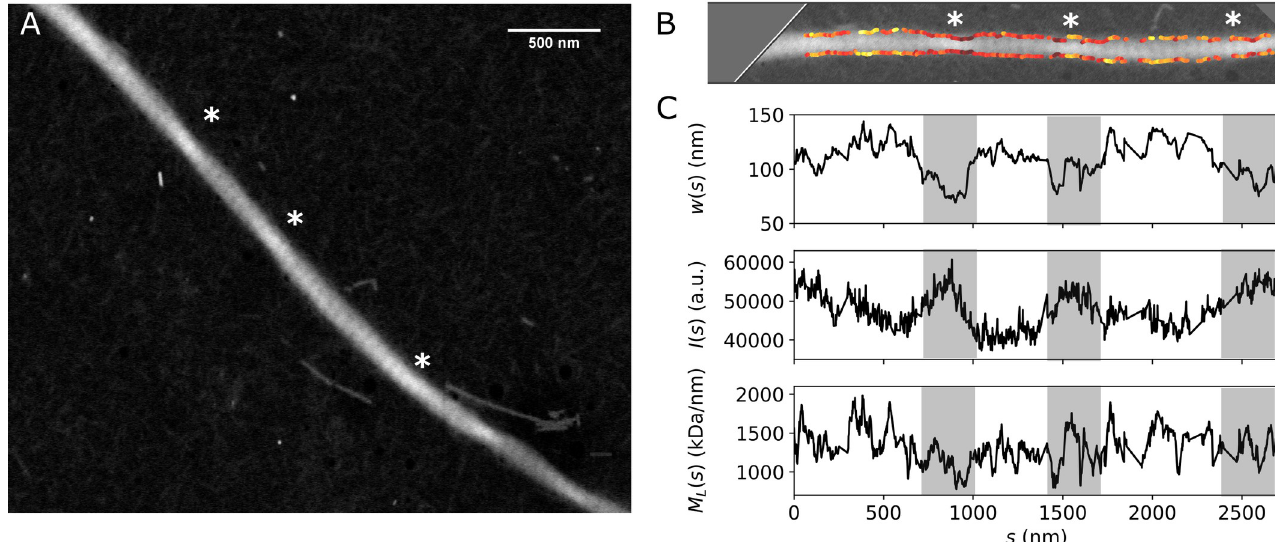
Fig 6. Fibril twisting. (A) STEM image of a single fibril from bovine telocollagen. The asterisks indicate the points where the intensity is enhanced and the morphology suggests the presence of fibril twists. (B) Cropped STEM image (shown in A), where the fibril has been rotated to be horizontal, and the contrast is optimized to show the twisting. The edge tracking is overlaid, with the M intensity I . The gray rectangles serve as a visual aid to identify the regions where fibril twisting is observed in the image shown in (B).